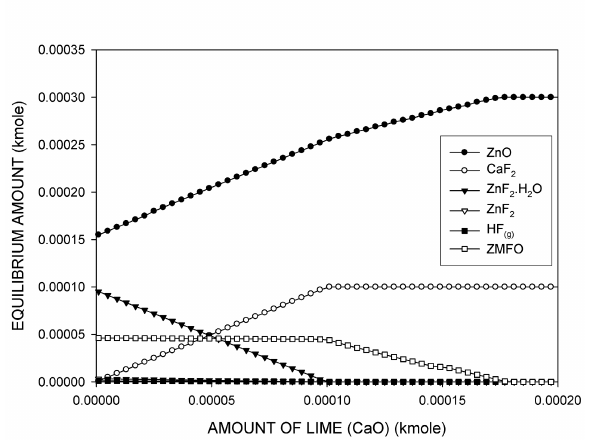
Figure 8. Effect of the amount of calcium oxide on the